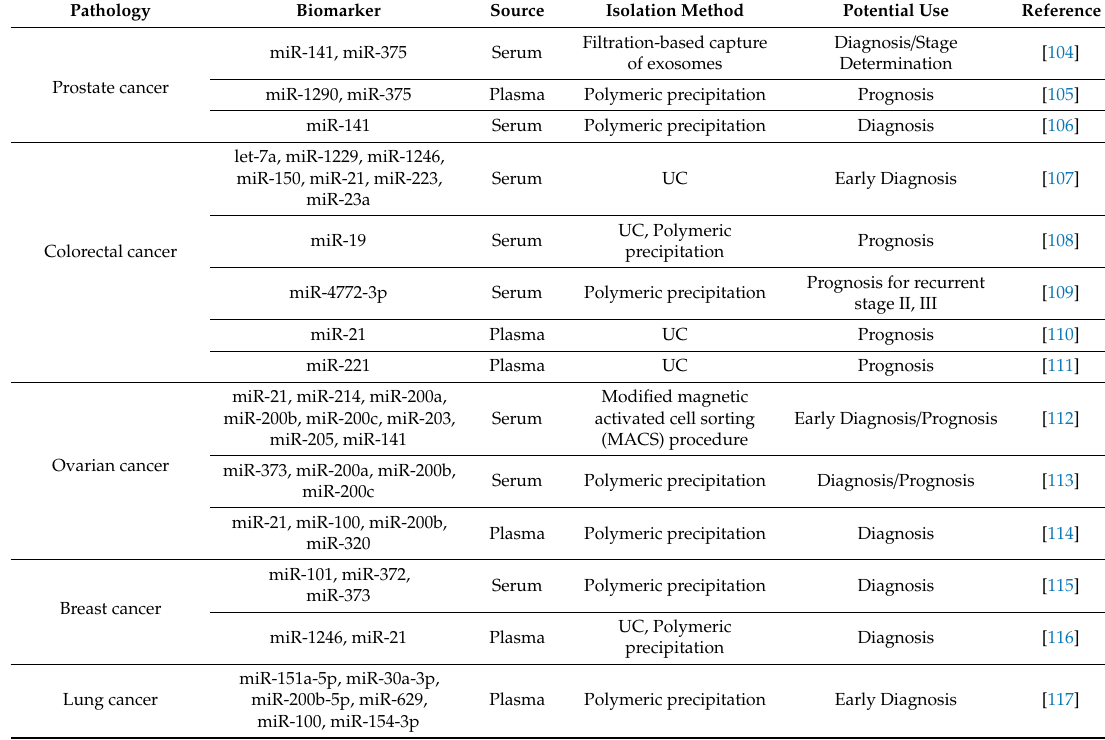
Table 2. Detection of exosomal microRNAs as tumor biomarkers in serum and